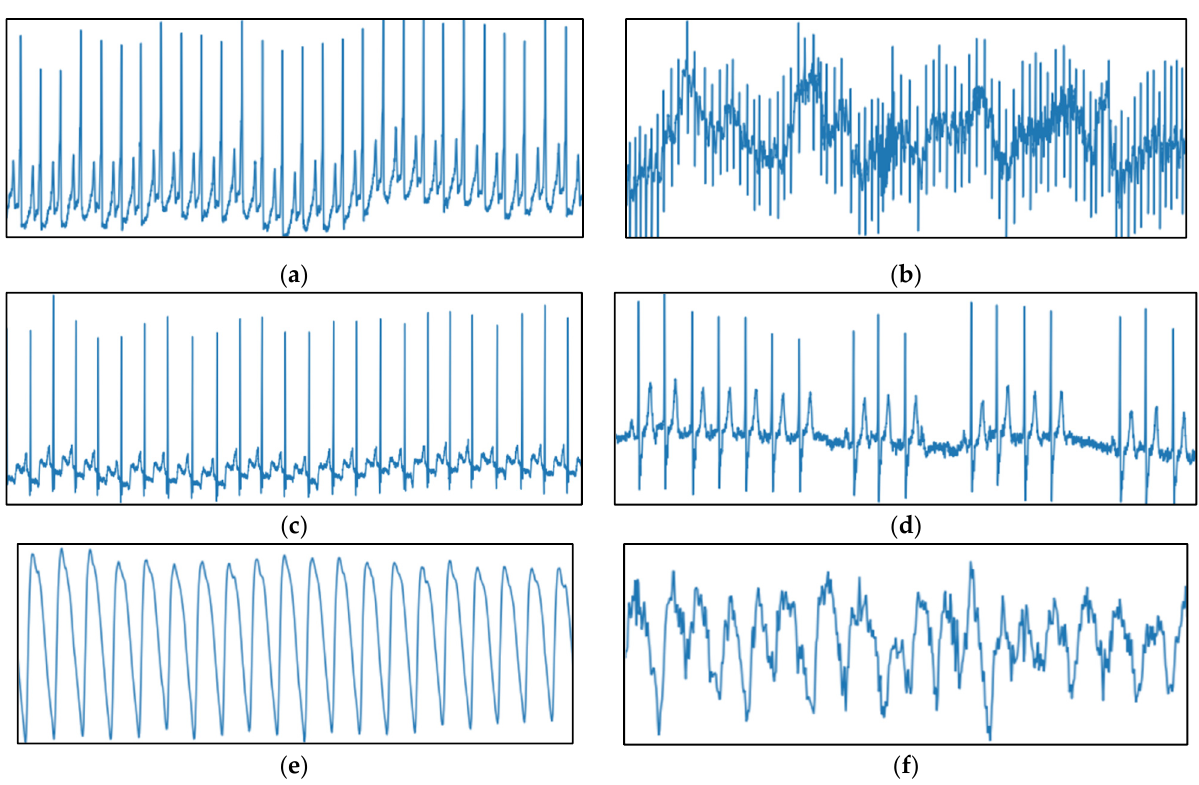
Figure 4. Sample 30-s heart rhythm instances represented as raw amplitude (y-axis) against time (x-axis) from ECG datasets; ( a ) NSR ECG from AF-DB (Patient 4015); ( b ) AF ECG from AF-DB (Patient 4043); ( c ) NSR ECG from ARR-DB (Patient 100); ( d ) AF ECG from ARR-DB (Patient 222) and PPG dataset; ( e ) NSR PPG (Patient 4002); ( f ) AF PPG (Patient 4012).